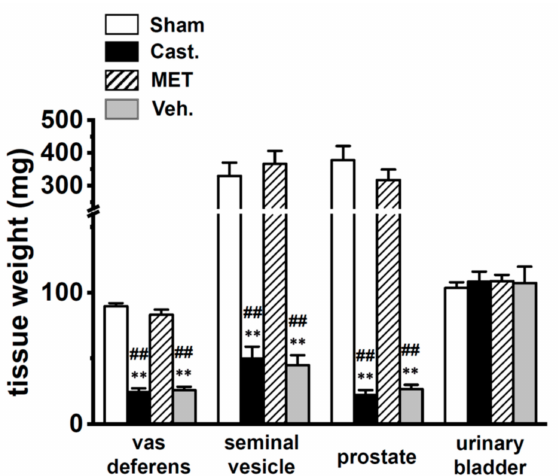
Figure 1. Changes in tissue weights by castration. Weights of the vas deferens, seminal vesicles, prostate, and urinary bladder in each group of male rats. Open columns—sham-operated group ( Sham ), black columns—castrated group ( Cast. ), hatched columns—methyltestosterone (MET)-treated group ( MET ), and gray columns—vehicle-treated group ( Veh. ). ** p < 0.01 versus sham-operated; ## p < 0.01 versus MET-treated ( n =